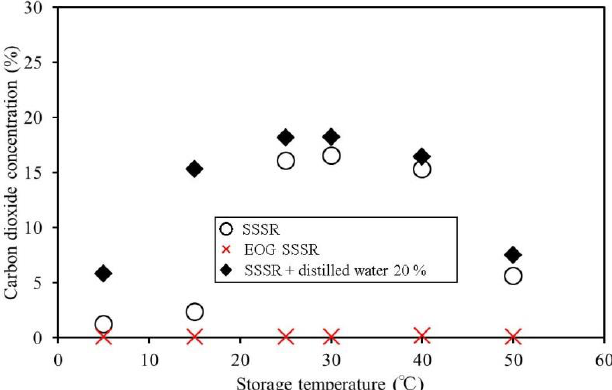
Figure 18. Oxygen concentrations as functions of storage temperature for SSSR samples.